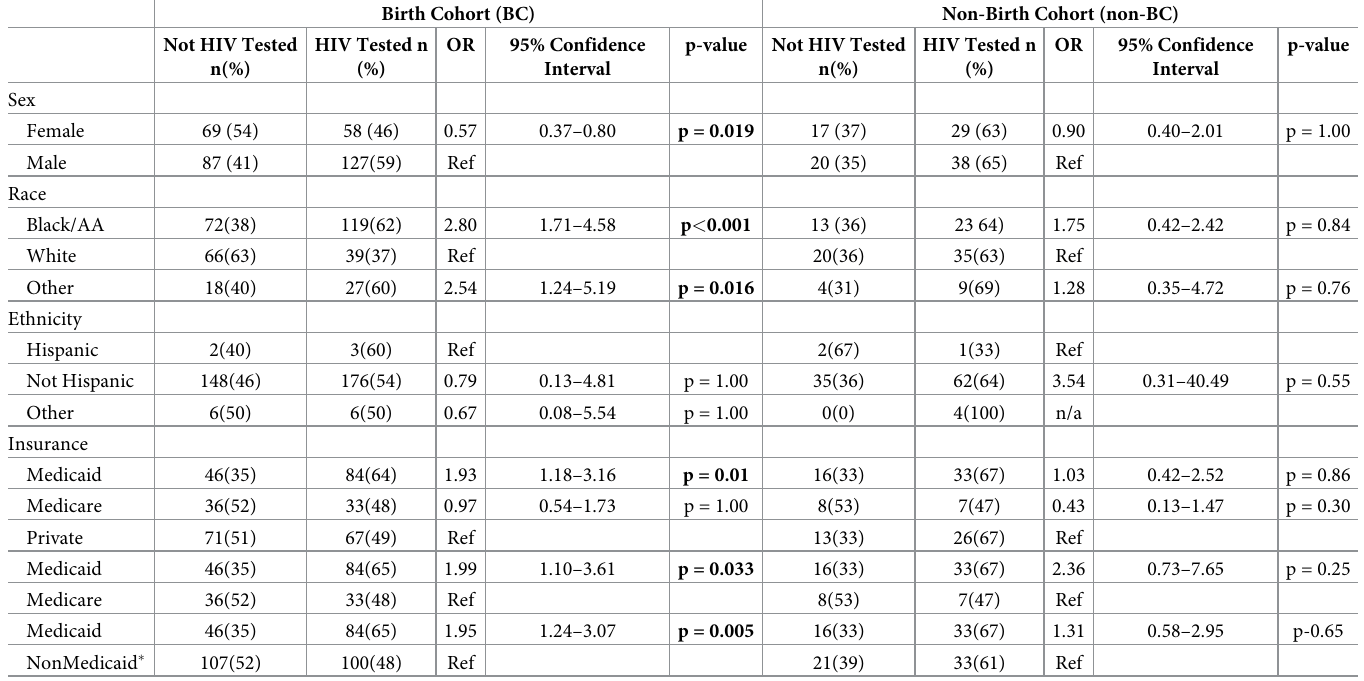
Table 3. Univariable analysis of HIV testing rates in the BC and Non-BC.